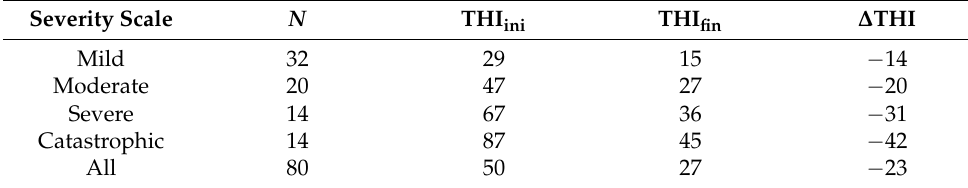
Figure 8. Average THI score change over time for the different distress groups. Shaded areas around the mean THI display the 95% confidence intervals. Table 4. Average THI reduction by severity scales.